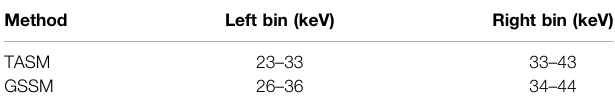
TABLE 2 | The energy bins selected by TASM and